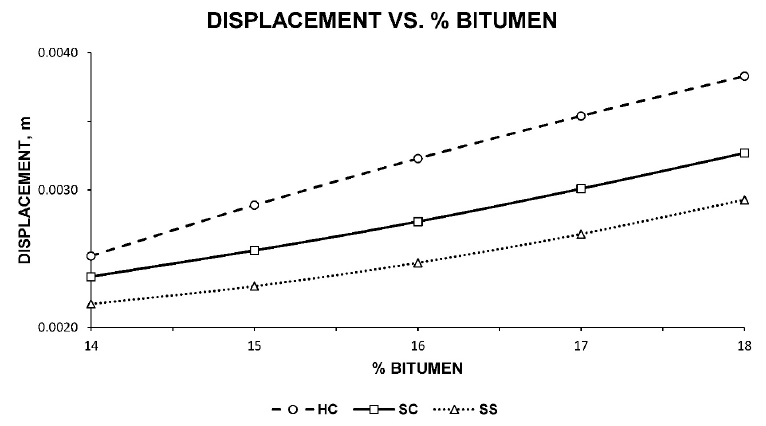
Figure 10. Marshall deformation of the HC, SC, and SS families of bituminous mixtures according to the percentage of bitumen.